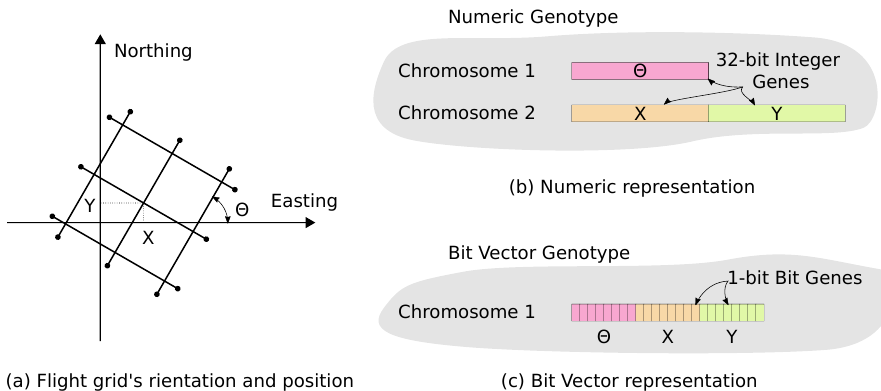
Figure 3. Representations of a flight path candidate for GA optimisation in which: ( a ) is the parame- terization of a flight path candidate; ( b , c ) are two alternative representations: Numeric and